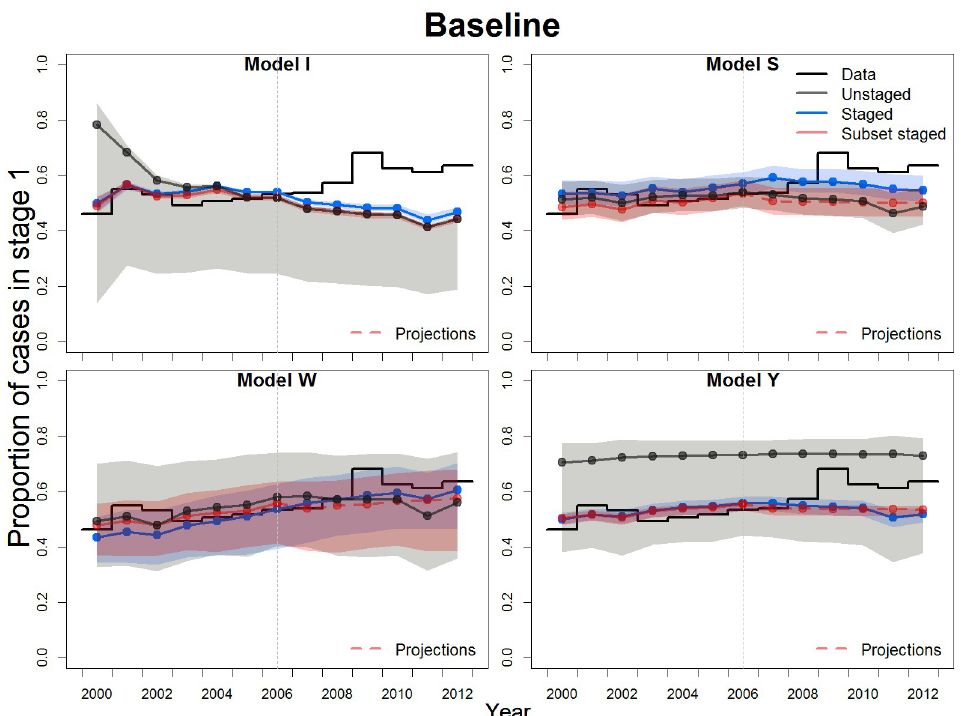
Fig 2. Proportion of stage 1 cases. The estimates for the four models fitted to three different configurations of the data under the baseline strategy are shown. The posterior median is shown as a point and 95% CIs shaded. Dashed lines indicate projections from the fit to the subset staged